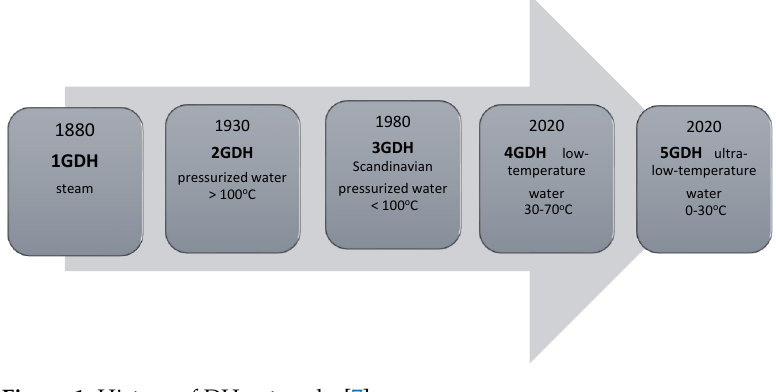
Figure 1. History of DH networks [7].